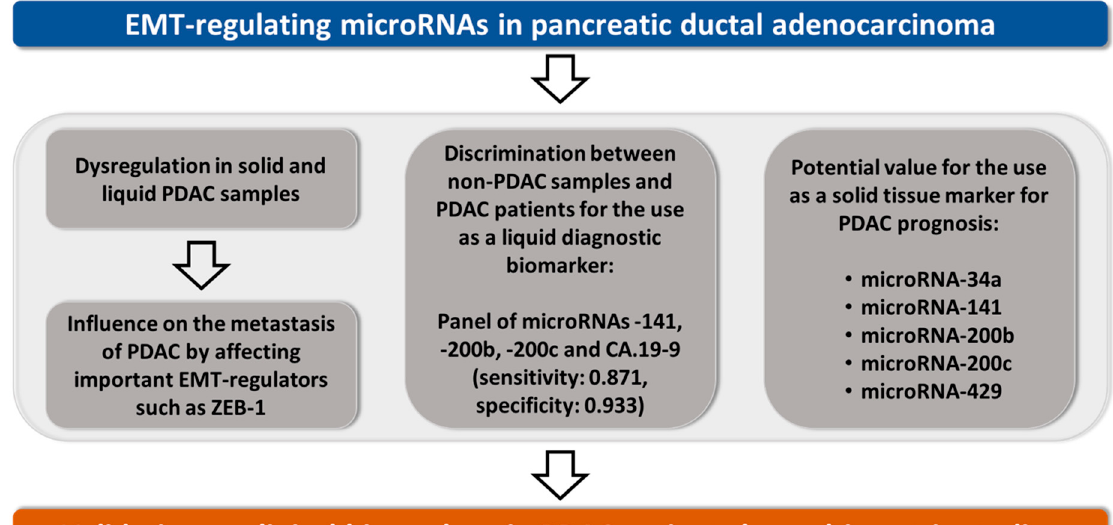
Figure 6. Scheme of the main findings of this study.